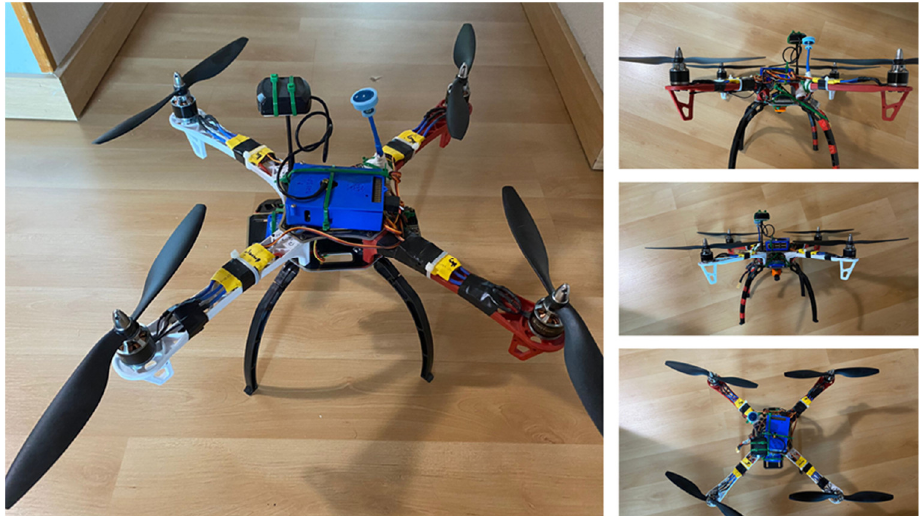
Figure 10. Assembled UAV